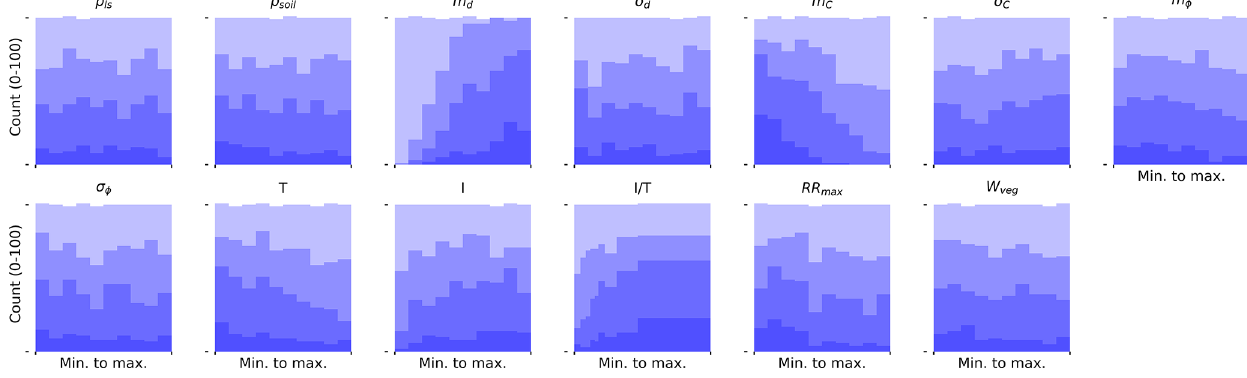
Figure 6. Histograms of different subsamples of the LHS parameter sets for the Trub study area. The shading (from light to dark) corresponds to subsamples retaining only the x % highest parameter sets in terms of the unstable ratio; the fractions shown are as follows: 1, 0.7, 0.4 and 0.1.